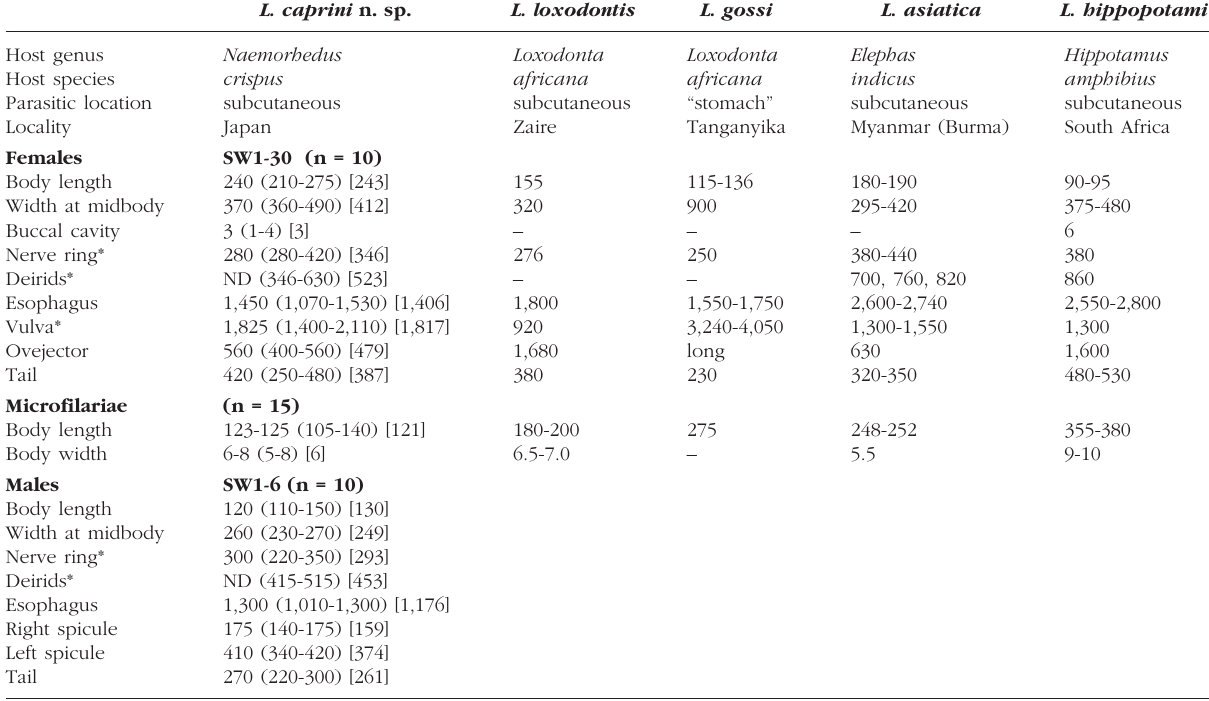
Table I. Measurements of adults and microfilariae of Loxodontofilaria caprini n. sp. and other